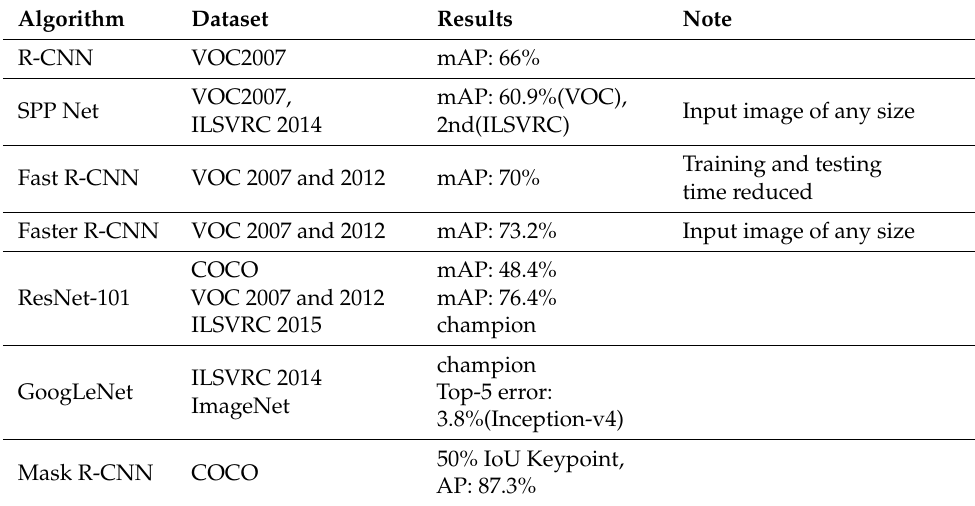
Table 3. The state-of-the-art two-stage image detection algorithms, which can be used to detect videos by